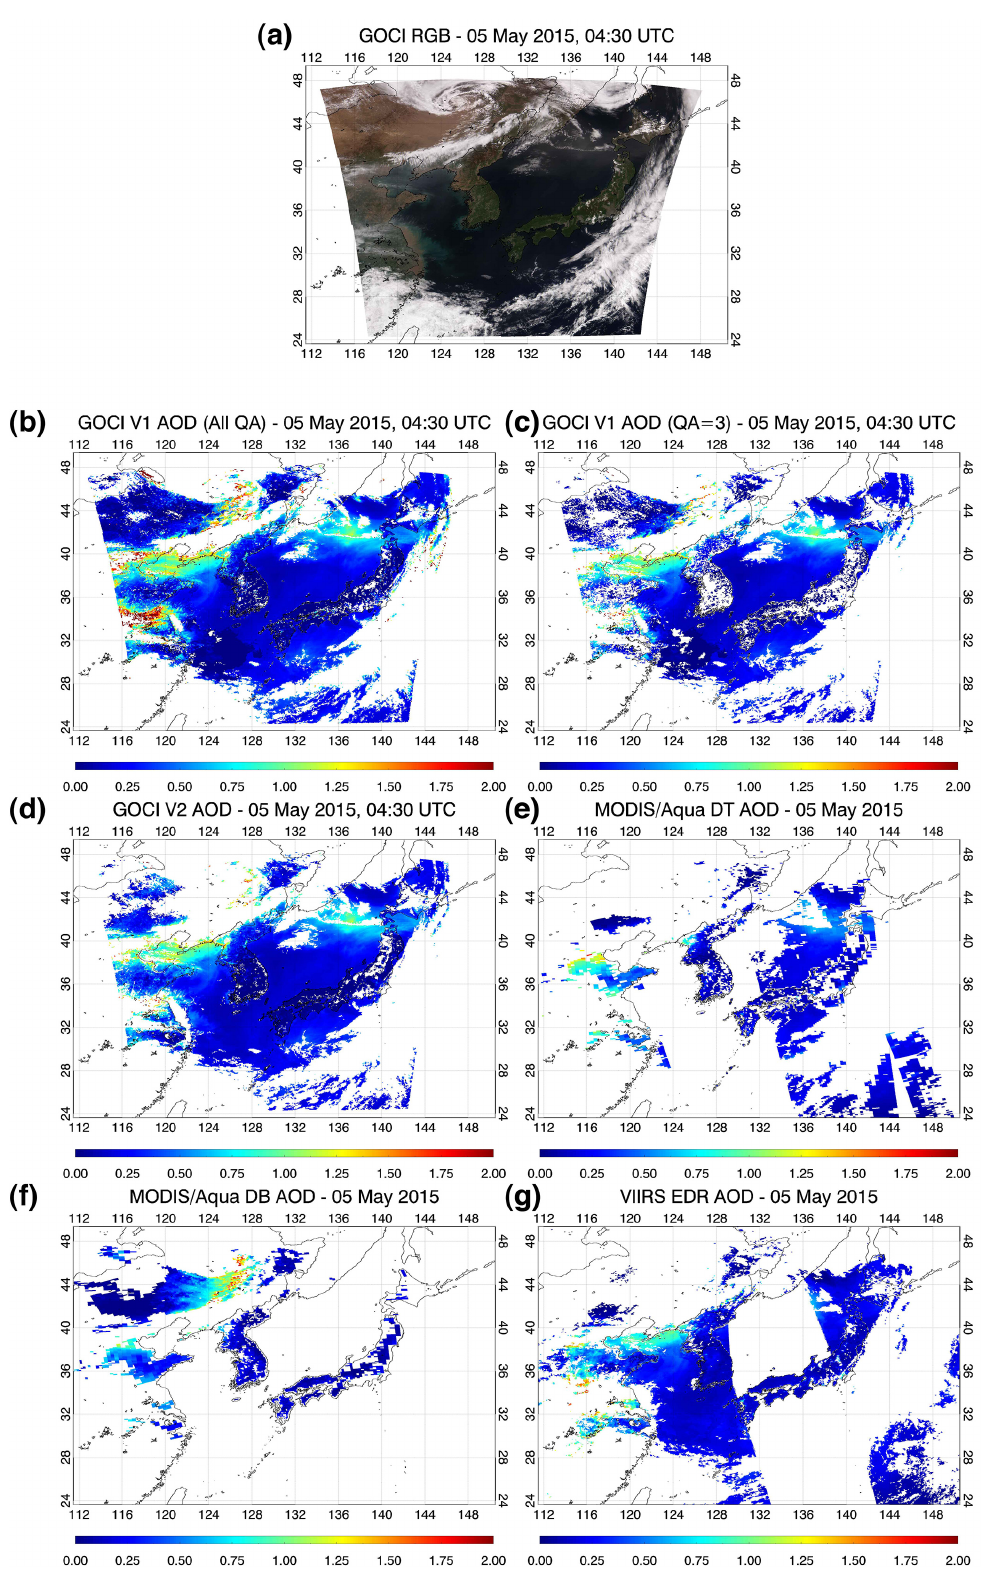
Figure 2. (a) GOCI RGB images and AOD for (b) GOCI V1 all QA, (c) GOCI V1 QA3, (d) GOCI V2, (e) MODIS/Aqua DT, (f) MODIS/Aqua DB, and (g) VIIRS EDR algorithms on 5 May 2015 over Northeast